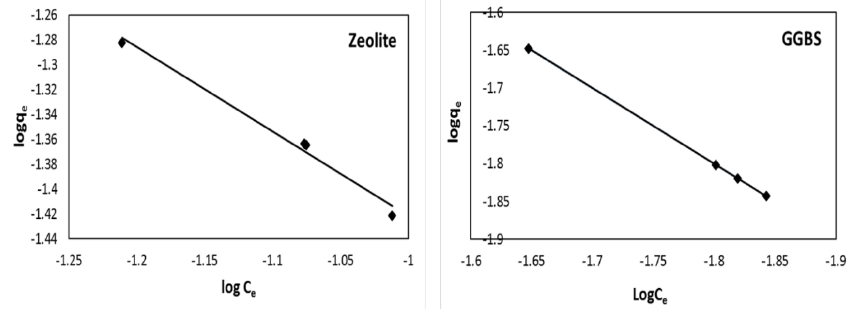
Figure 5. Freundlich model for adsorption of Cr(VI) onto zeolite and GGBS.